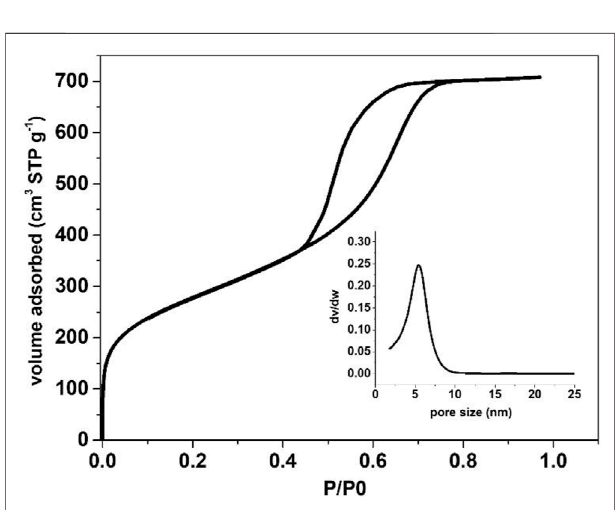
FIGURE 10 | N2 physisorption isotherm of spherical silica particles created via adapted recipe of zeotile-4 from Martens et al. (2011) and Pulinthanathu Sree et al. (2012) using Pluronic P85 copolymer.